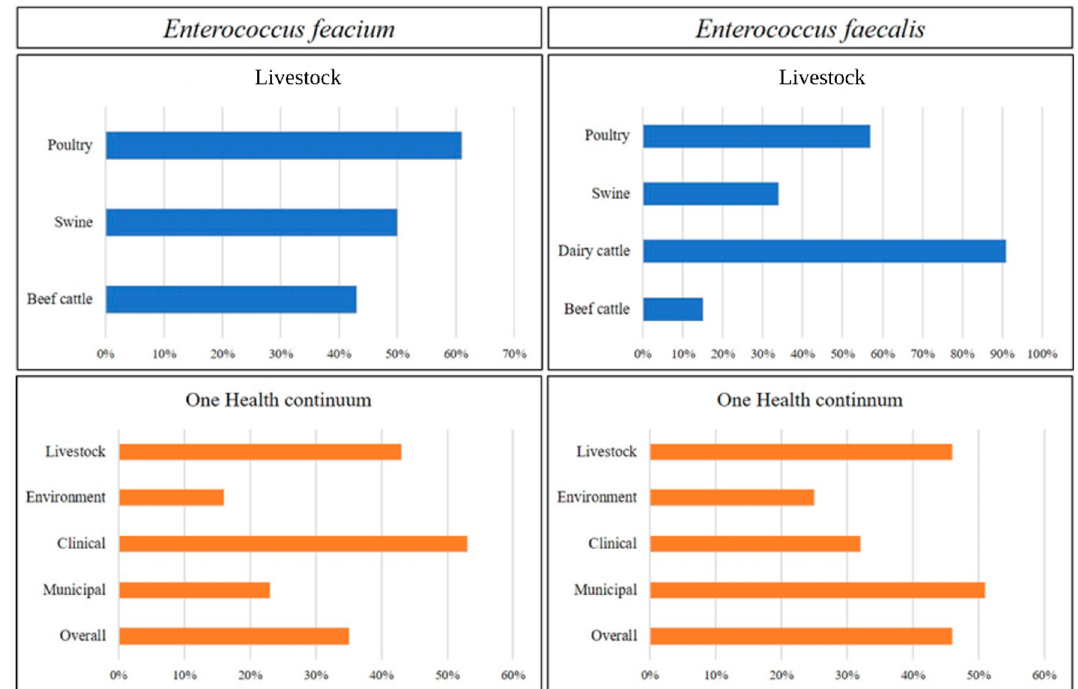
Figure 2. Multidrug resistant Enterococcus faecium and Enterococcus faecalis across One Health continuum.